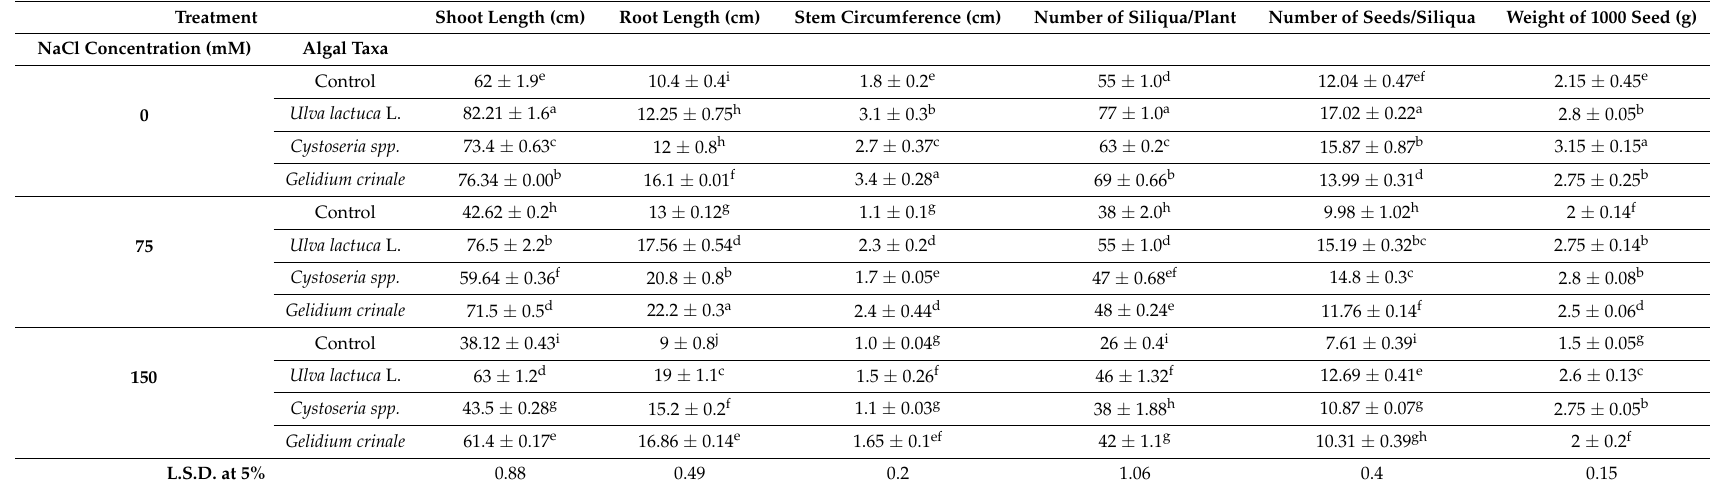
Table 3. The impact of Ulva lactuca L., Cystoseria sp., and Gelidium crinale soil treatment on the yield characteristics of canola plants grown under different levels of salinity. Data are presented as the mean ± SD ( n = 50).